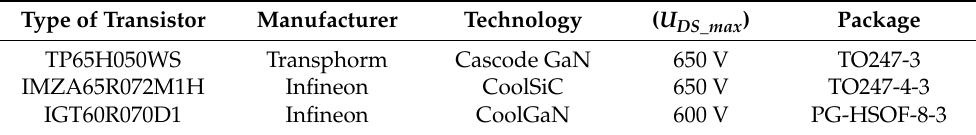
Figure 7. Efficiency characteristic of analyzed non-optimized PFC converter and power loss dependency on the output power of converter.